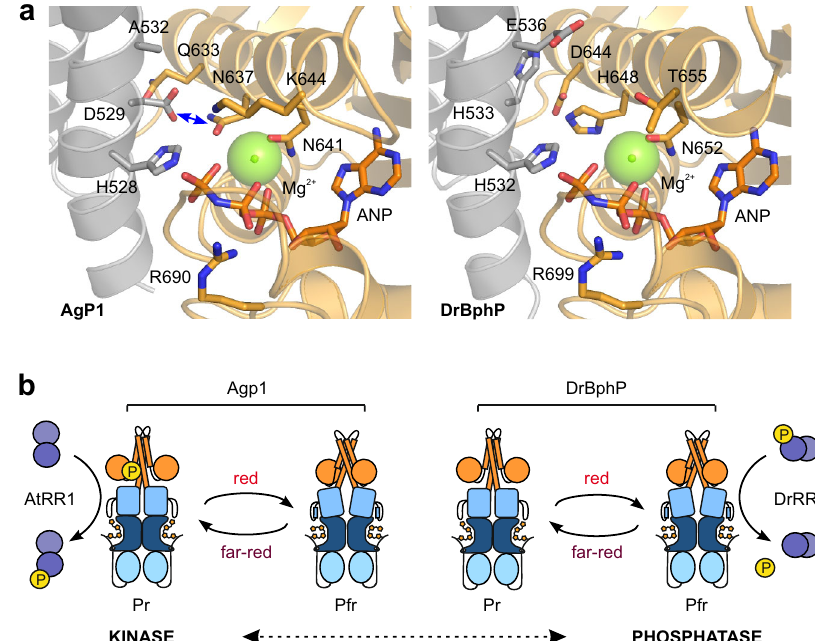
Fig. 6 Structural comparison of residues important for the phosphotransfer reaction. a Homology models of Agp1 and DrBphP based on the histidine kinase domain structure of HK853/EnvZ chimera in its phosphotransfer state (PDB 4KP4) 12 . The central residues are denoted as sticks, dimerization, and phosphohistidine (DHp) domain is shown in gray, and the catalytic ATP-binding (CA) domain is shown in orange. In Agp1, the potential interaction between His528 and Asn637 is shown as a blue arrow. b Proposed kinase and phosphatase activities of Agp1 and DrBphP. Many histidine kinases can function as both kinases and phosphatases, which may be governed by their DHp orientations 17 . In the case of the two phytochromes studied here, red light induces Pfr conformations that favor phosphatase activity. In the resting Pr state, the HK conformation favors kinase